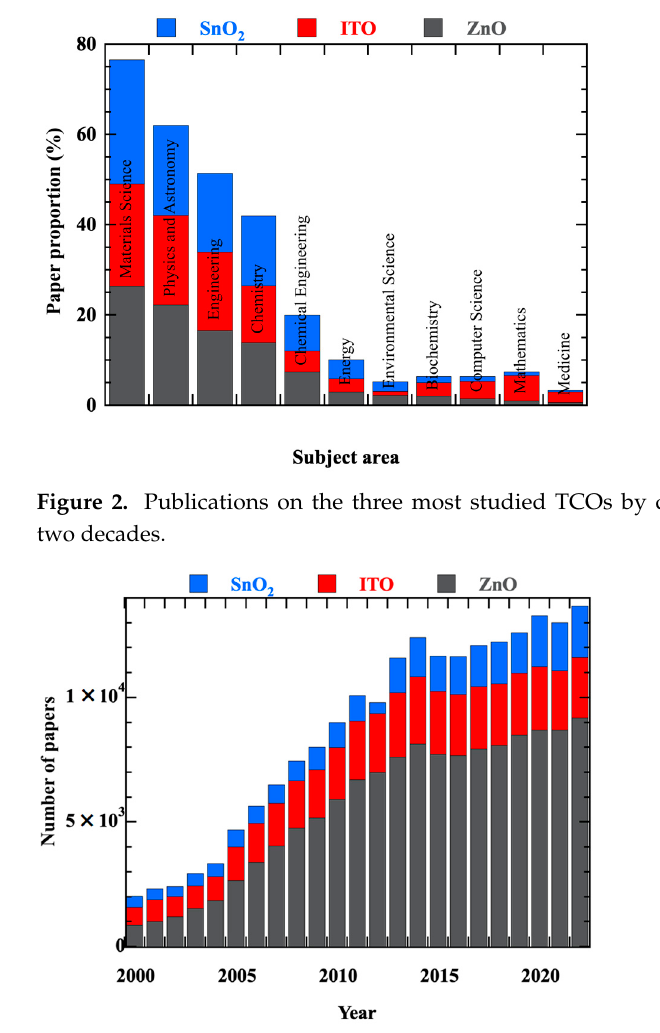
Figure 3. Number of publications devoted to each of the three most studied TCOs over the last two decades.